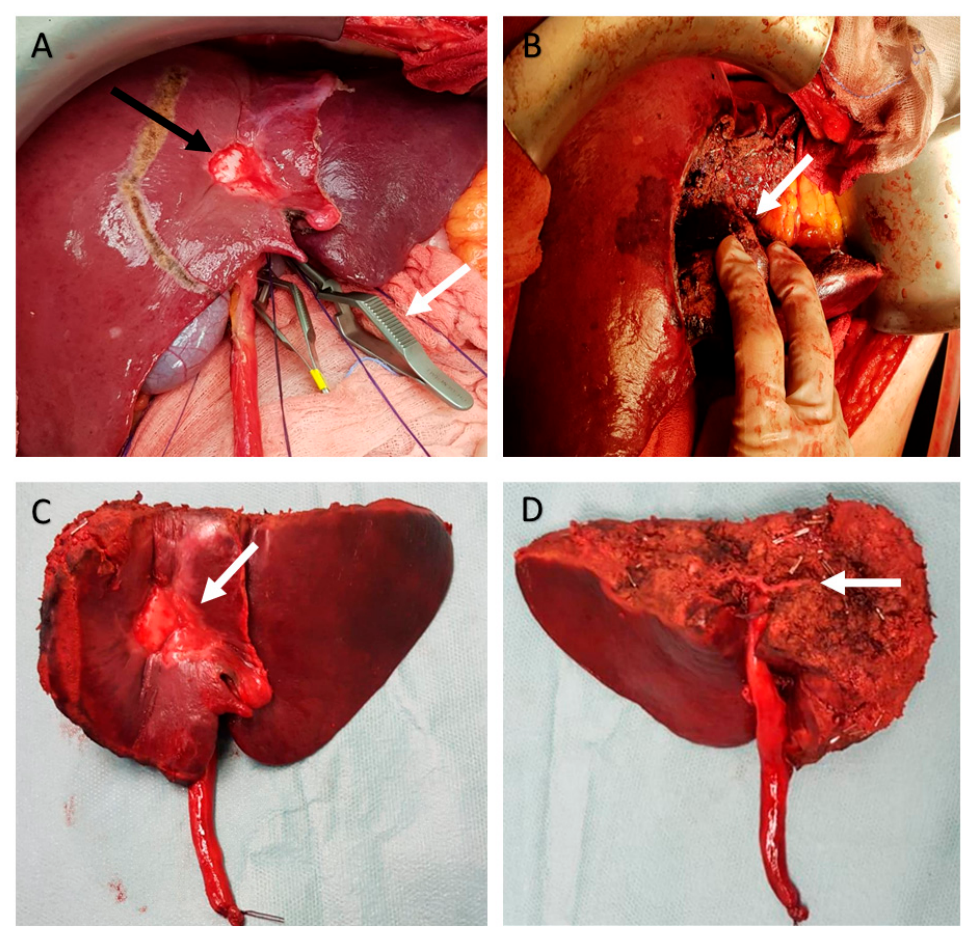
Figure 3. Intra-operative and specimen pictures. This figure illustrates the case of patient with a tumor invading the distal part of the UPLPV and the right horn of the LPV; the patient underwent left anterior sectorectomy. ( A ) The delimitation of the LAS (the planned transection line was drawn with electrocautery on the liver surface); the right boundary of the LAS is represented by the middle hepatic vein that was identified with ultrasound-guided technique; the intersegmental plane between S2 and S3 was identified occluding the origin of the portal pedicle for S3 with a bulldog clamp (white arrow) with consequent discoloration of S3; for the identification of the intersegmental plane between S4b and S4a, the occlusion of the portal pedicle at the right horn was not practicable because of tumor’s invasion (black arrow), so it was identified with ultrasound-guided technique in a plane between the tumor and the origin and course of proximal independent portal pedicle for S4a. ( B ) The parenchymal transection was accomplished without sectioning any segmental portal pedicle until the skeletonization of (white arrow) was obtained; the sectorial Glissonean pedicle of LAS includes the UPLPV and the peripheral arterial and biliary branches for S3 and S4b. ( C ) The specimen of left anterior sectorectomy (anterior; white arrow indicates the tumor). ( D ) The specimen of left anterior sectorectomy (posterior; white arrow indicates the stapled stump of the sectorial Glissonean pedicle of LAS).